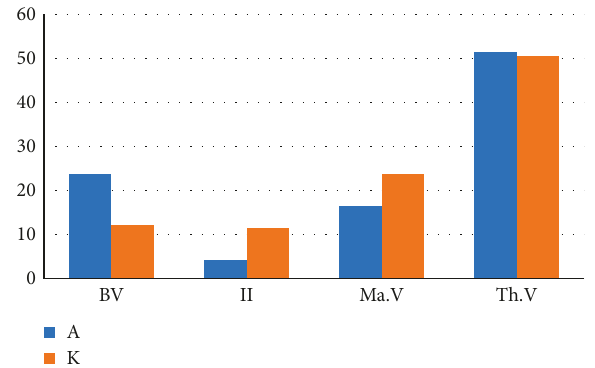
Figure 20: The distribution chart of structural components of regenerated cancellous bone tissue 4 weeks after the formation of a bone defect and introduction of suspensions of calcium hydroxide alone and calcium hydroxide with nanodispersed cerium dioxide. Where Bv is the relative volume of the newly formed bone tissue (%), II is the relative volume of granulation tissue (%), MaV is the relative volume of the bone marrow (%), and Th.V is the relative volume of the tooth and periodontal tissue (%) (A—with cerium dioxide and K—without cerium